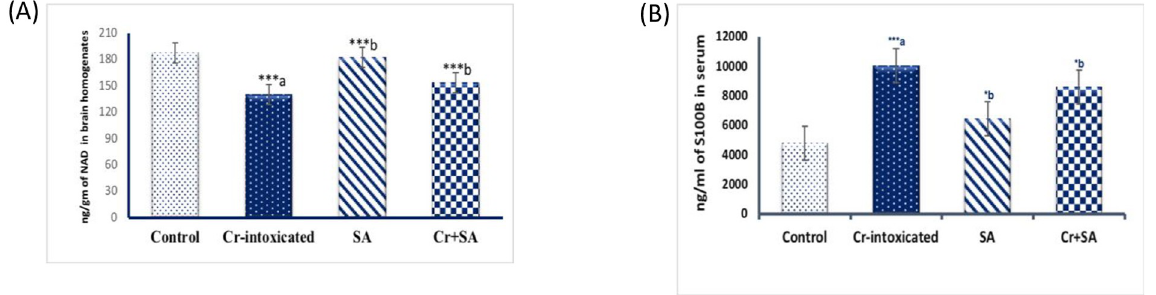
Fig 3. Impacts of Cr and SA on (A) NAD + , (B) S100B protein levels in brain tissues and serum respectively. Data are expressed as mean ± SE (n = 10). ��� a p � 0 . 001 compared to standard control group. � b p � 0 . 05 compared with Cr group and ��� b p � 0 . 001 compared to Cr